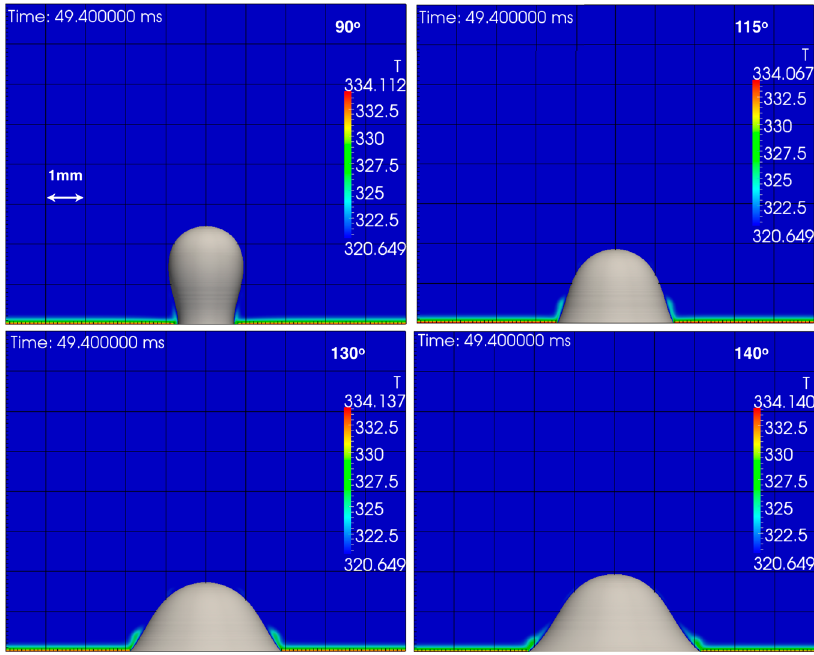
Figure 18. Evolution of a R113 bubble, at t = 49.40 ms, for equilibrium contact angles higher than 80°.